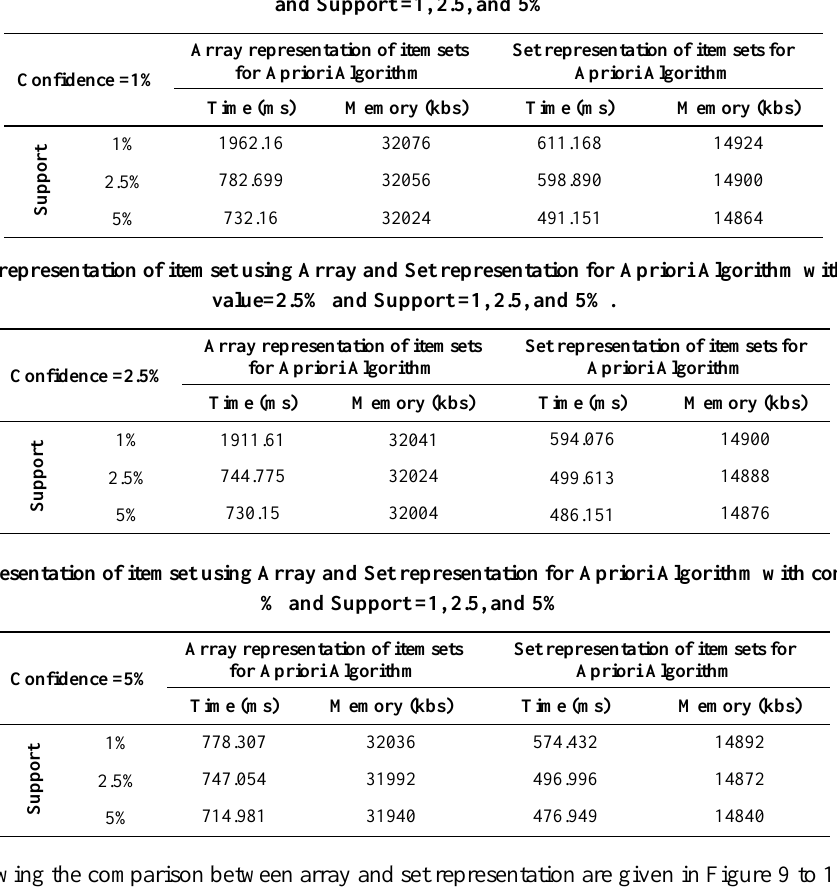
Table 5. The representation of itemset using Array and Set representation for Apriori Algorithm with confidence value=1%